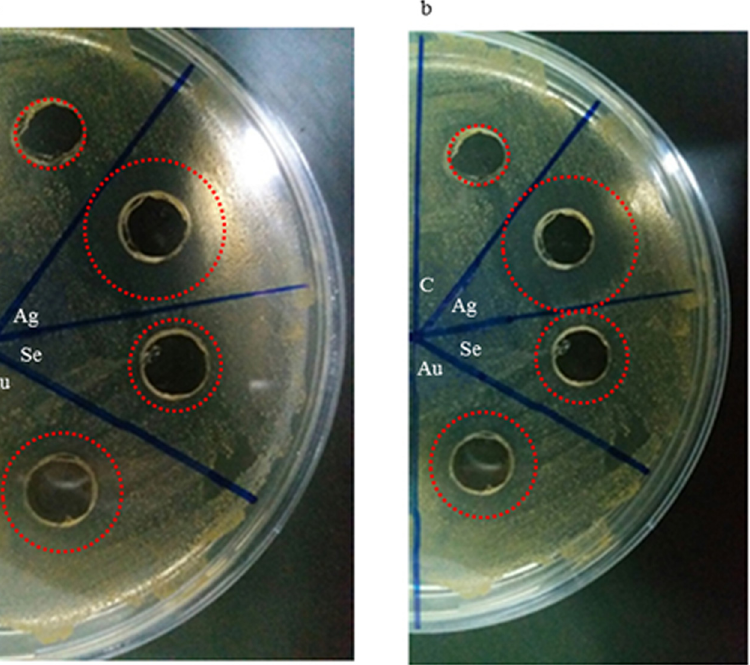
Figure 4: Bactericidal activity of the synthesized Se NPs, Ag NPs and Au NPs using co ff ee bean extract against E. coli ( a ) and S. aureus ( b )